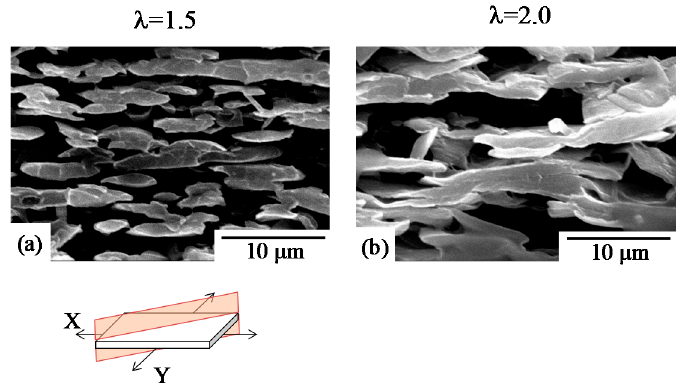
Figure 8. SEM micrographs of the cross section of 70/30 PC/PMMA obtained by simultaneous biaxial stretching at draw ratios λ of 1.5 and 2.0. ( a ) λ = 1.5; ( b ) λ = 2.0.